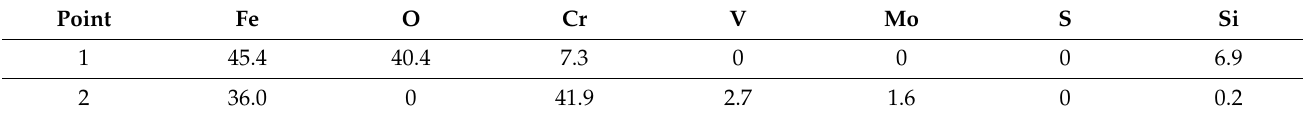
Table 4. The atomic percentage of SKD11 in SEM images by